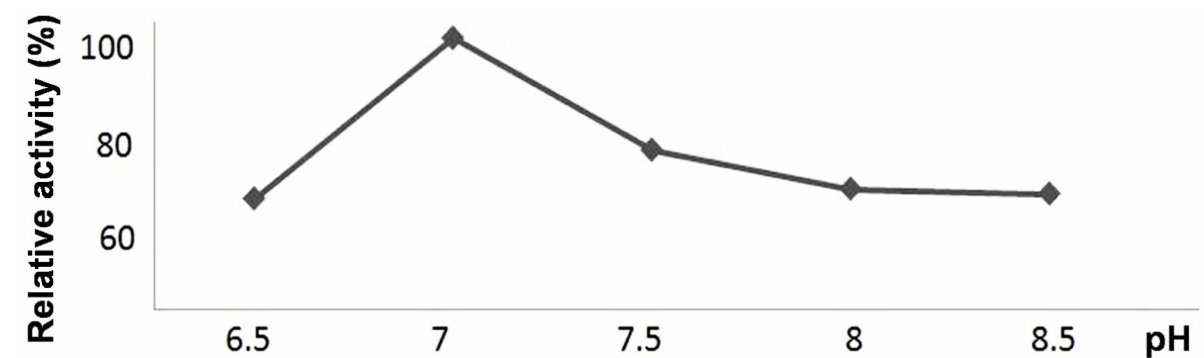
Figure 3. The pH dependences of catalytic activities of the recombinant CYP440A18 enzyme towards 13-HPOT.